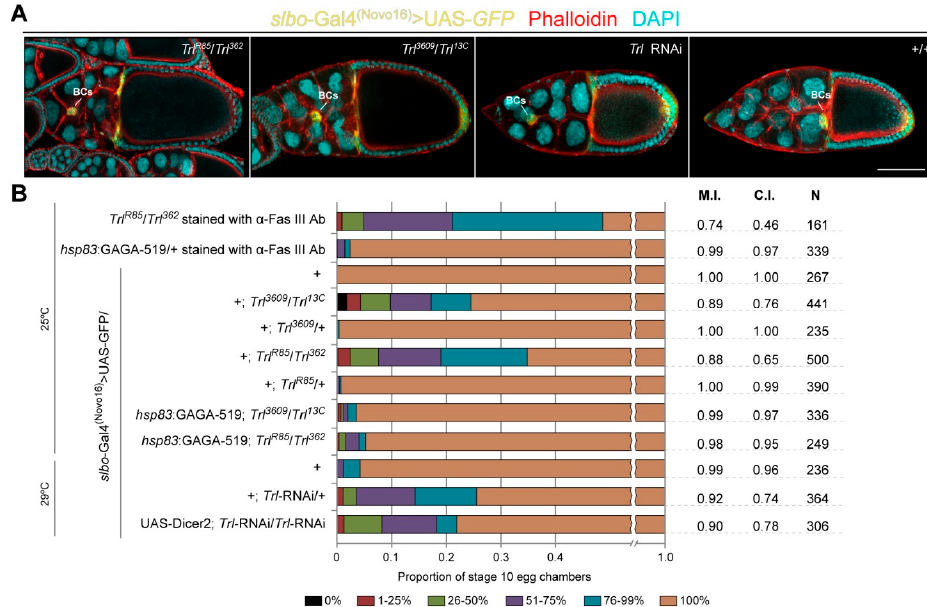
Figure 1. Border cell (BC) migration is delayed in Trithorax-like ( Trl ) mutant egg chambers. ( A ) Stage 10 egg chambers from Trl mutant and Trl +/+ flies labelled with slbo -Gal4 > UAS- GFP (yellow), Phalloidin (red) and DAPI (cyan). Note that in the shown examples of Trl mutant egg chambers, BCs had not reached the nurse cell–oocyte boundary. Scale bar is 100 µm. ( B ) Quantification of the BC migration phenotypes in stage 10 egg chambers of the indicated genotypes. The combination of the slbo -Gal4 (Novo16) driver [30] with the UAS- GFP reporter construct or immunostaining with anti-Fasciclin III antibody ( α -Fas III Ab) was used to mark BCs. UAS-Dicer2 was used to increase efficiency of RNAi. “+“ indicates wild-type second or third chromosome(s) depending on the genotype. For quantitation, the nurse cell region of egg chambers was divided into 6 groups according to the percentage of the total distance travelled by BCs: 0% (black), 1–25% (dark red), 26–50% (light green), 51–75% (violet), 76–99% (blue) and 100% (brown) [30]. M.I., C.I. and N denote the migration index, the completion index and the number of egg chambers examined, respectively.